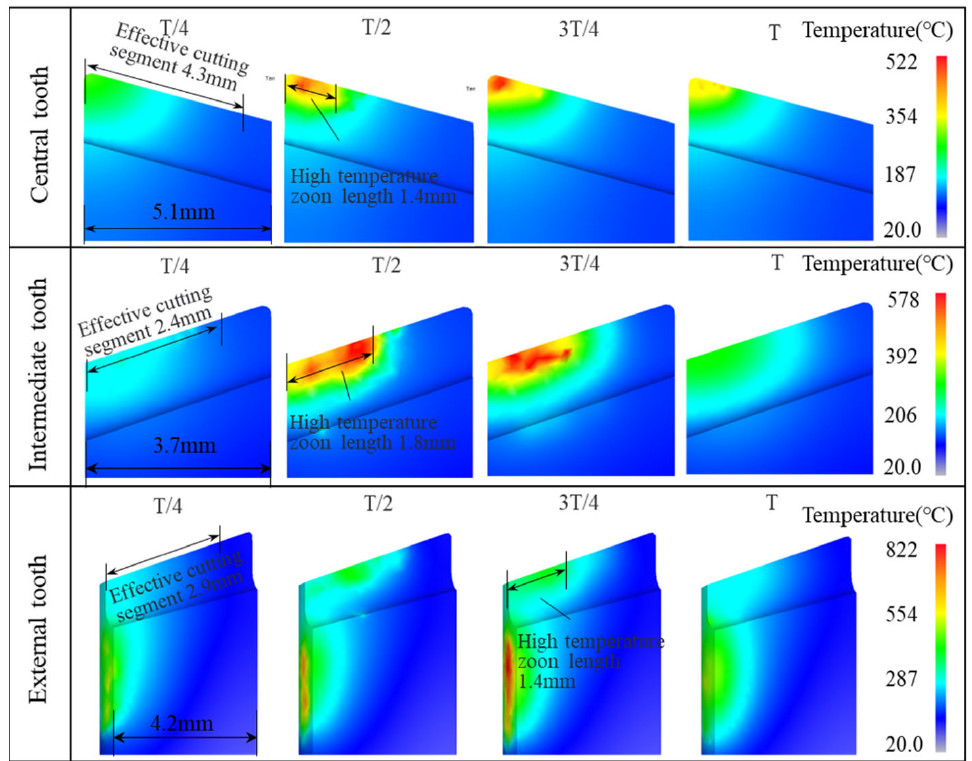
Figure 7. Variation temperature field of the cutter teeth for one vibration cycle of vibration drilling.